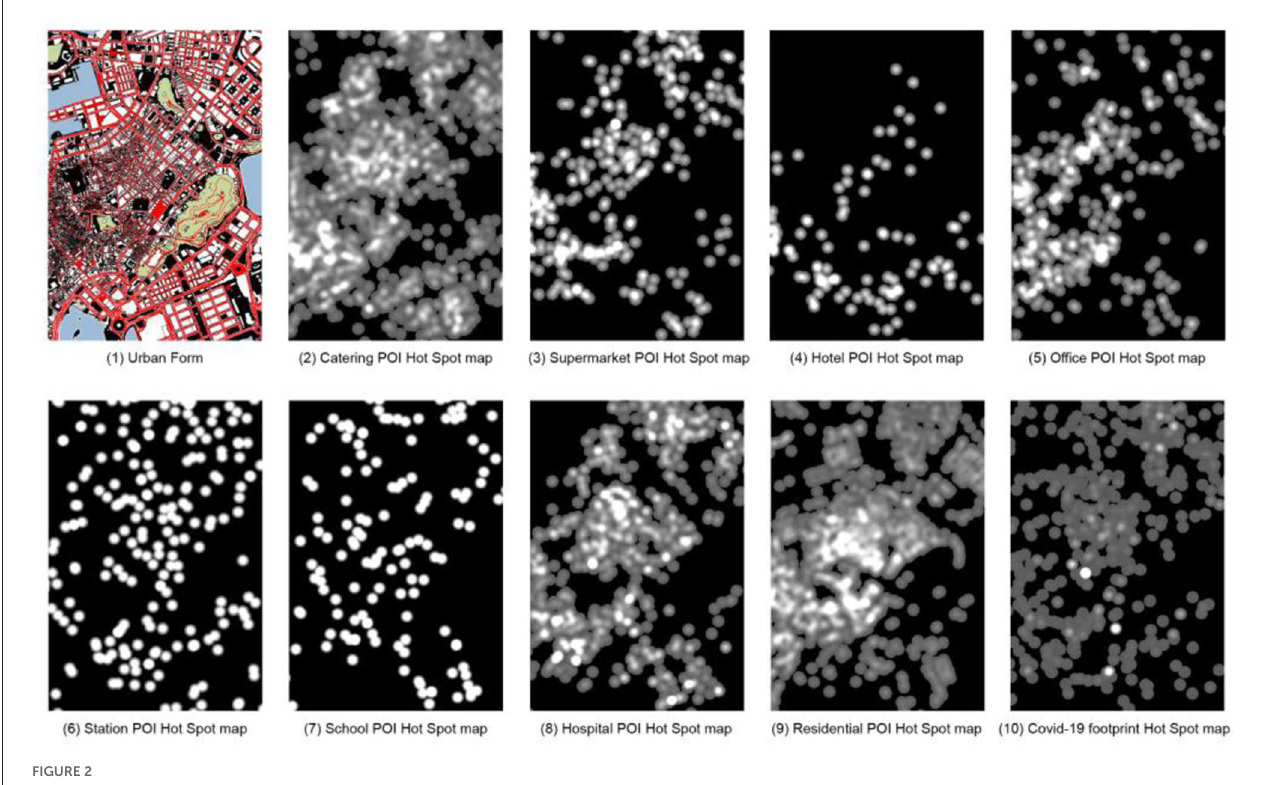
FIGURE2 Area of sample